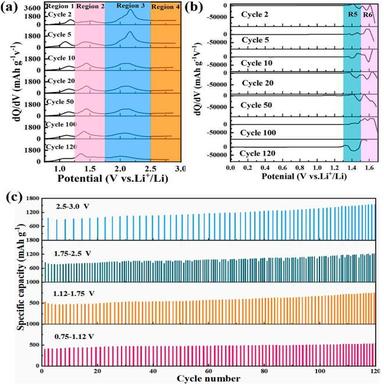
Difference capacity plots of MoS2/C@G in (a) charging, (b) discharging; (c) capacity of reversible charging vs. number of cycles.